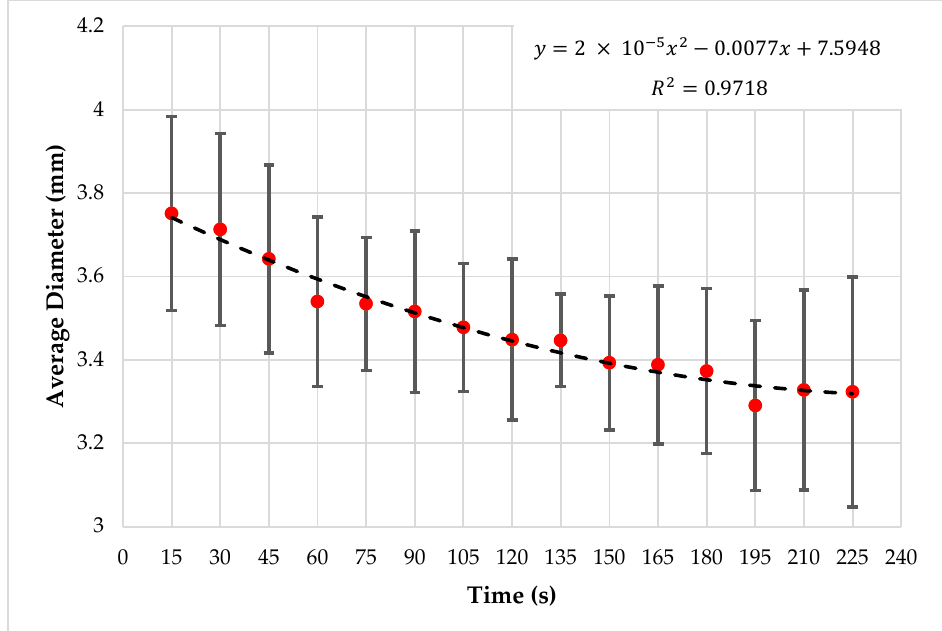
Figure 15. Time vs. average droplet diameter.